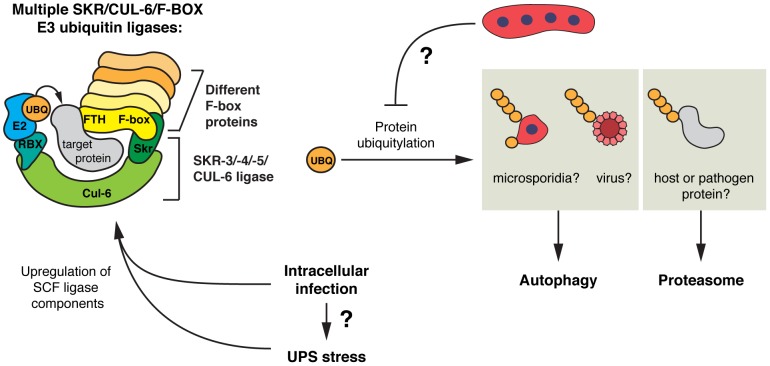
Model for SCF E3 ligases and ubiquitin-mediated responses to intracellular infection in C. elegans.Intracellular microsporidia or viral infection triggers the expression of SCF ligase components in C. elegans, including a large number of F-box genes, the cullin cul-6, and Skp1-related genes, skr-3, -4, and -5. Due to the modularity of the SCF ligase complex, many SCF ligases with vast substrate recognition potential may be formed, which could recognize pathogen-derived proteins or host proteins. Ubiquitylation of substrates leads to their degradation by the proteasome or by autophagy, with large substrates such as microsporidia cells, potentially viral particles, and protein aggregates (not shown), targeted by autophagy, and individual pathogen or host proteins by the proteasome. N. parisii parasite cells may be able to suppress or evade ubiquitylation. Both intracellular infection and UPS stress can induce SCF ligase components, and greater demand on the UPS during intracellular infection may contribute to upregulation of SCF ligase components. See Discussion for more details.